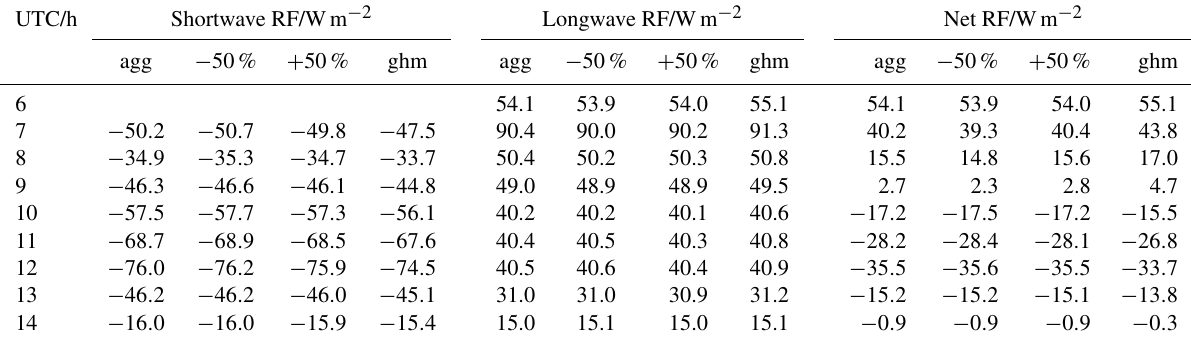
Table 2. The sensitivity study on how changing the uncertainty of R eff ( ± 50%) and assumed crystal shapes (aggregates (agg) and general habit mixture (ghm) according to Baum et al., 2014) impact the resulting radiative forcing in Fig. 7. UTC/h Shortwave RF/Wm −